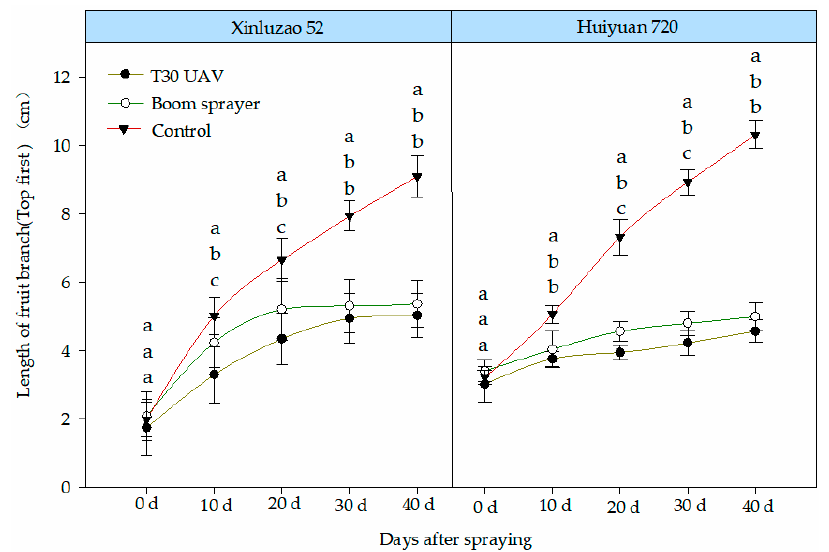
Figure 7. Effects of chemical topping agent sprayed by two sprayers on the length of fruit branches (top first). Different lowercase letters indicate significant differences between treatments at the 5% probability level ( p < 0.05).